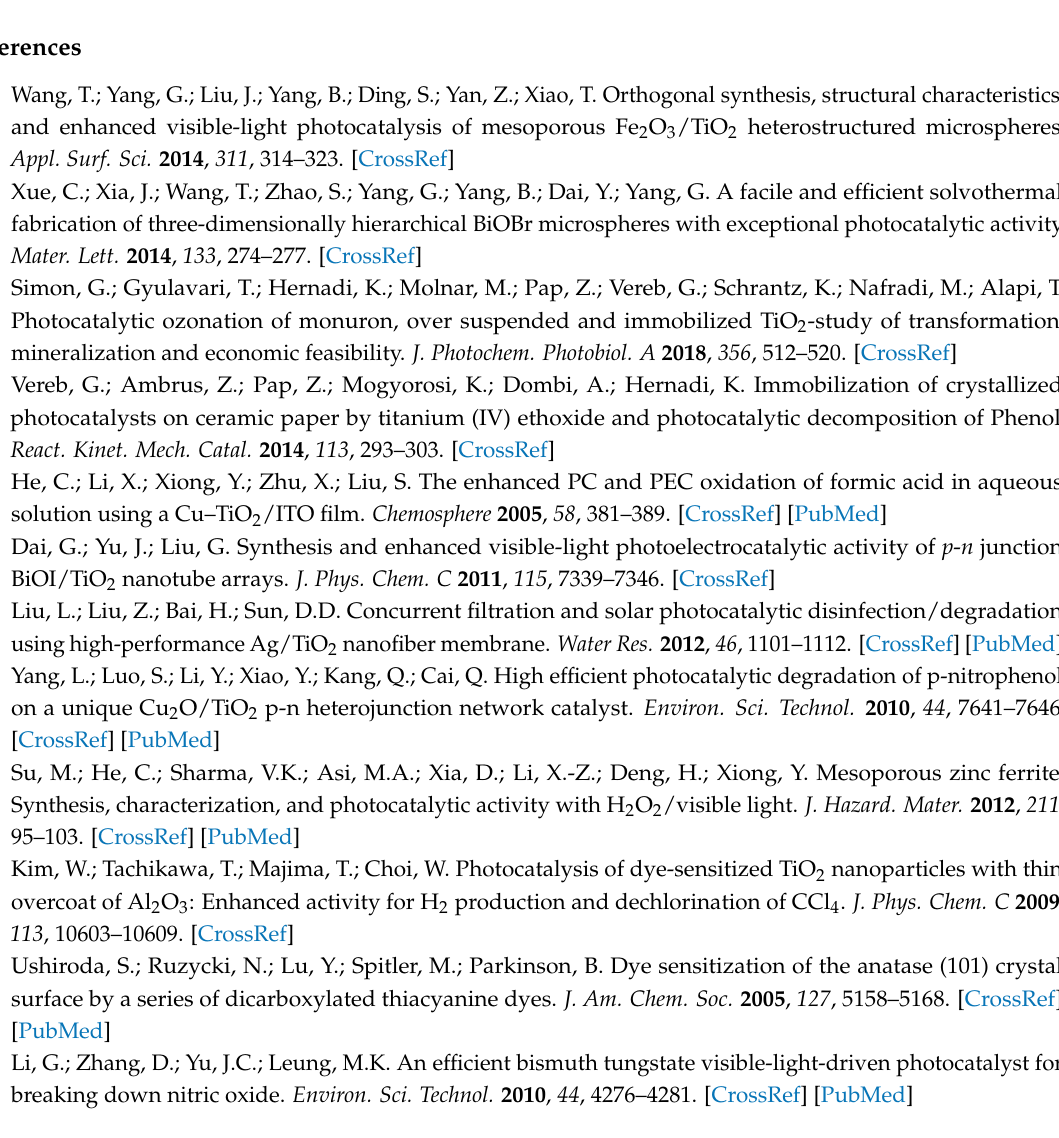
s1; Figure S1: Photodegradation of MO by BiOBr-G with different concentrations of plant extract, Figure S2: Schematic diagram for synthesis of BiOBr using Azadirachtaindica leaf extract, and images of BiOBr-C and BiOBr-G samples, Figure S3: Representation of the dark study at 30 min, 60 min and 90 min for BiOBr-C and BiOBr-G, Section S4: Calculation of Crystallite sizes of BiOBr-C and BiOBr-G, Figure S5: TEM images of BiOBr-C and BiOBr-G, Figure S6: Degradation efficiency of MO with leaf extract, Figure S7: Photodegradation of phenol by BiOBr-C and BiOBr-G, Section S8: Band position calculations of BiOBr-C and BiOBr-G. Author Contributions: Conceptualization & Supervision, S.G. (Seema Garg), K.H., A.C., S.S., and